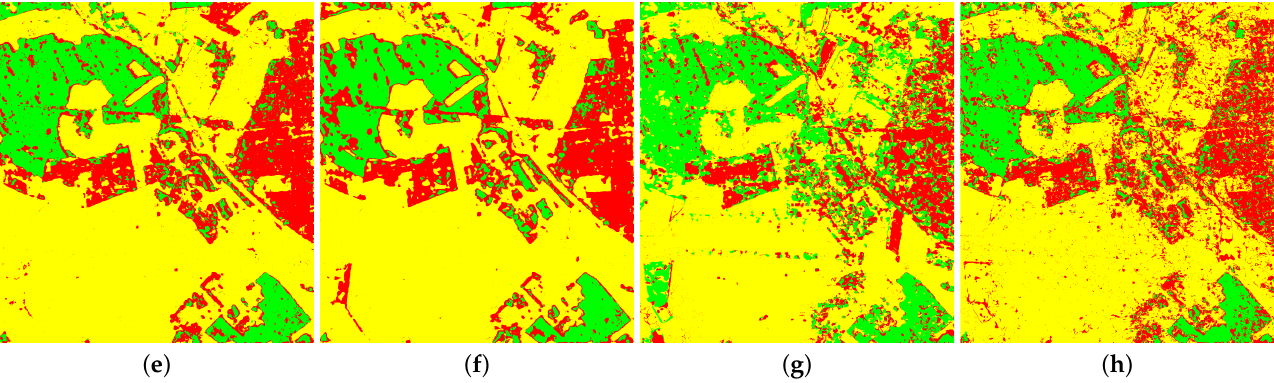
Figure 9. Prediction result of Oberpfaffenhofen image obtained by different methods, including ( a ) SVM on the learned parameters, ( b ) SVM on all the parameters, ( c ) ANN on the learned parameters, ( d ) ANN on all the parameters, ( e ) AE on the learned parameters, ( f ) AE on all the parameters, ( g ) AEFT on the learned parameters, and ( h ) AEFT on all the parameters.